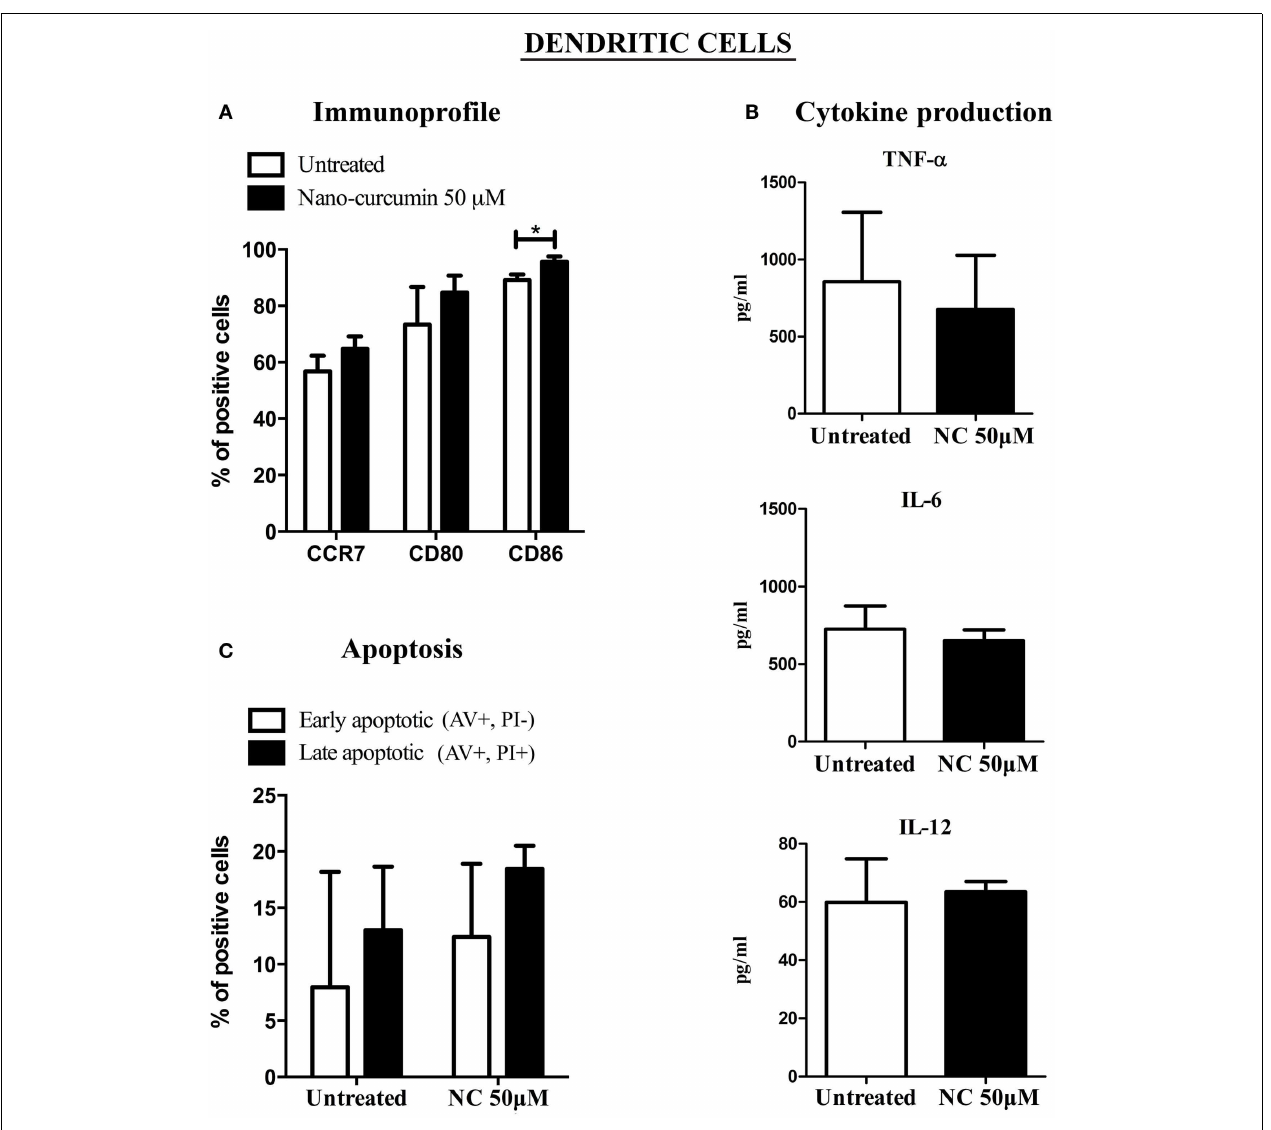
show that nano-curcumin does not change the cytokine production profile of the DCs (student’s two tailed paired t test, n = 3). (C) Flow cytometric detection of annexinV (AV) and propidium iodide (PI) shows that nano-curcumin does not induce apoptosis in DCs. Data are showing the percentage of early apoptotic (annexinV + /PI − ) and late apoptotic/necrotic (annexinV + /PI + ) populations (student’s two tailed paired t test, n =